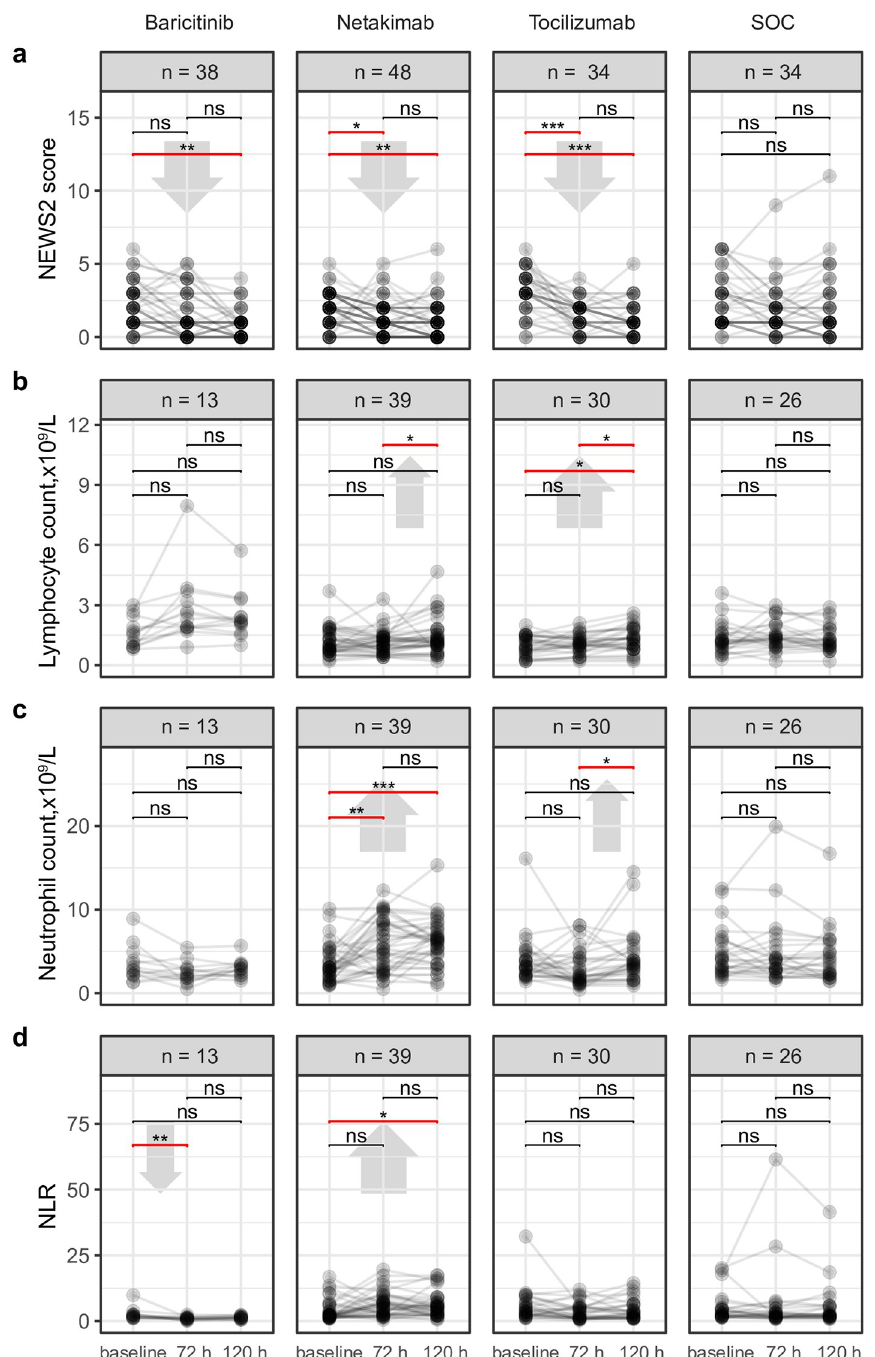
Fig 2. Individual dynamics of blood parameters. a —NEWS2 score; b —absolute lymphocyte count; c —absolute neutrophil count; d —neutrophil-to-lymphocyte ratio (NLR); n = number of patients with available values of the corresponding parameters. Wilcoxon test: � p < 0.05; �� p < 0.01; ��� p < 0.001; ns = non-significant.